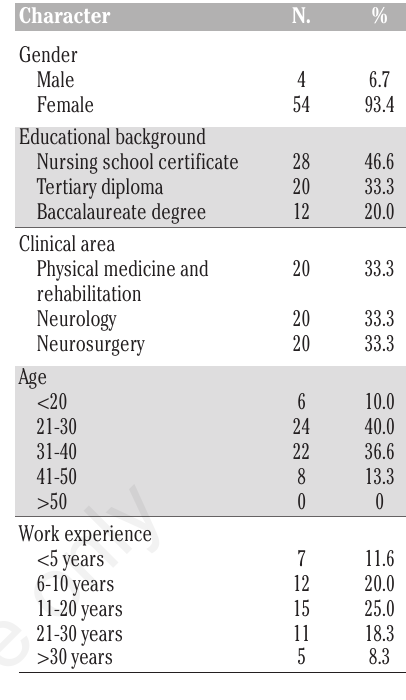
Table 1. The basic information of the nurses.